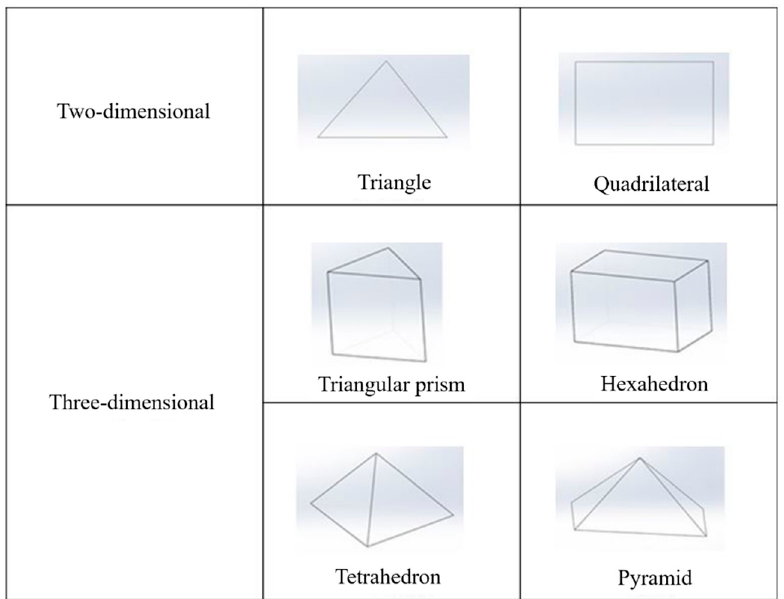
Figure 3. Element type.